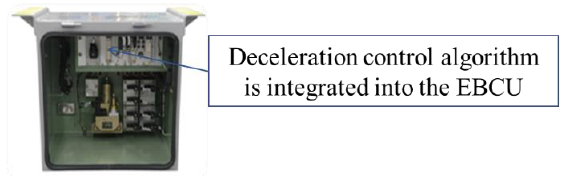
Figure 7. Brake controller prototype integrated with deceleration control function.